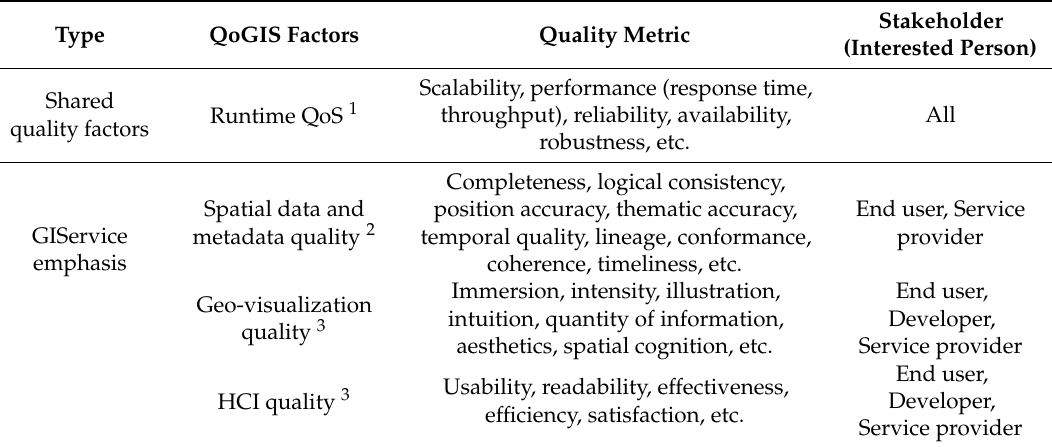
Table 1. QoGIS metrics